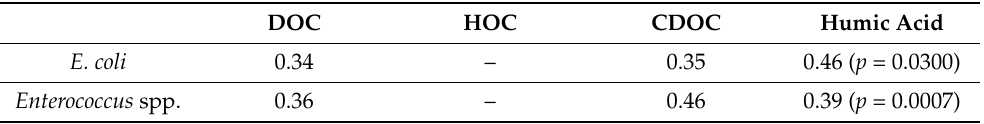
Table 1. Relationship between dissolved organic matter and its fractions with faecal indicator bacteria (FIB) using the coefficient of determination (R 2 ) of a curve fitted with a power equation as described in the text. DOC